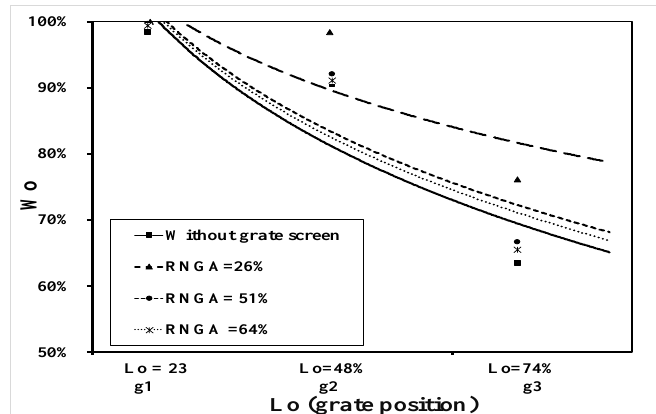
Figure 15. Relationship between relative width and relative grate distance for different grate inlet areas (Q = 3.3 L/s).